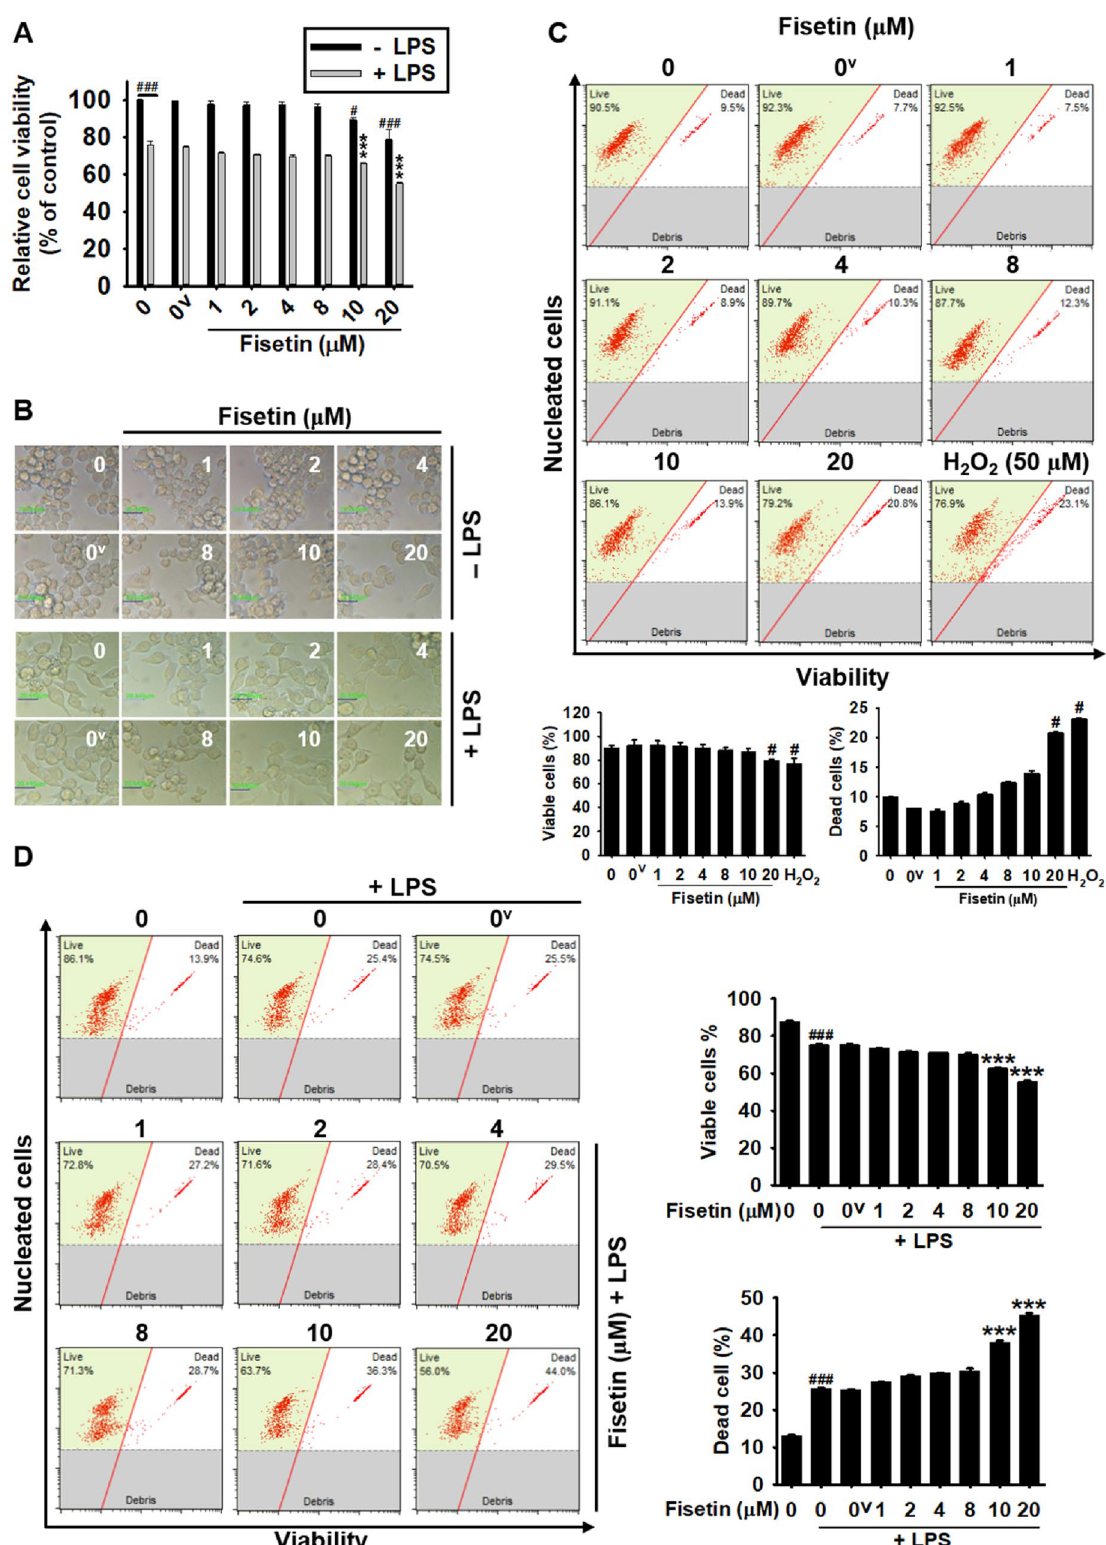
Figure 1. High concentrations of fisetin decreases the cell viability of RAW 264.7 macrophages. RAW 264.7 macrophages (1 × 10 5 cells/mL) were treated with fisetin (0–20 µM) for 24 h in the presence or absence of 500 ng/mL LPS. ( A ) An MTT assay was performed. ( B ) Microscopic images was taken using phase contrast microcopy (× 10). Scale bares 40 μm. ( C , D ) Total viable cells and dead cells in the absence ( C ) and presence ( D ) of LPS were determined by flow cytometry. Each value indicates the mean ± SEM from three independent experiments. Significant differences among the groups were determined using an unpaired one-way ANOVA with Bonferroni correction. ### p < 0.001 and # p < 0.05 vs. untreated cells; *** p < 0.001 vs. LPS-treated cells. 0 v , vehicle control (0.1%